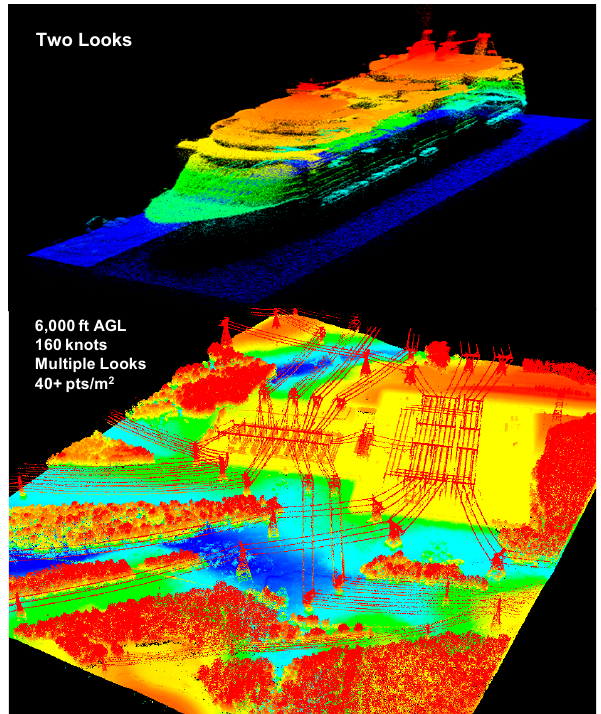
Figure 14. Top : Two passes of HRQLS-1 over a cruise ship docked at Ft. Lauderdale, Florida; Bottom : Multiple HRQLS-1 passes over a power line grid in North Carolina yielding over 40 points per square meter from an AGL of 1.83 km and an aircraft velocity of 296 km/h.